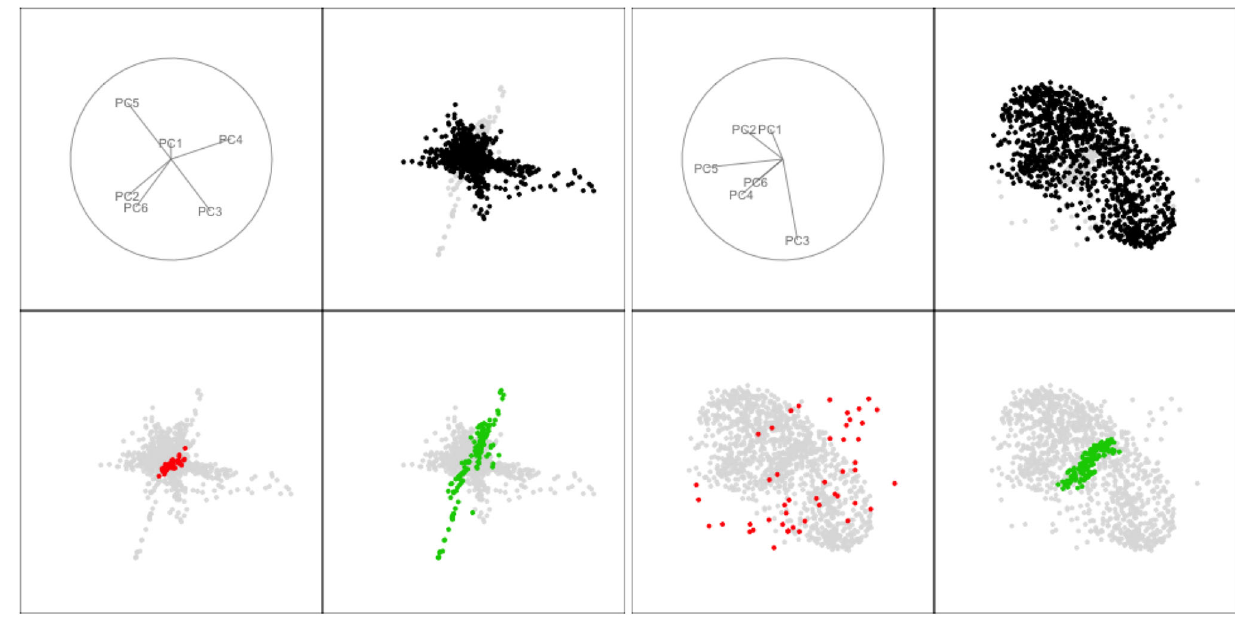
Fig. 8 As Fig. 6, but showing only selected results in the DIS clus- ter, i.e. DIS HERA1+2 (black), Charm SIDIS (red) and dimuon SIDIS (green). The left view is for PCA1 (see animation here) shows